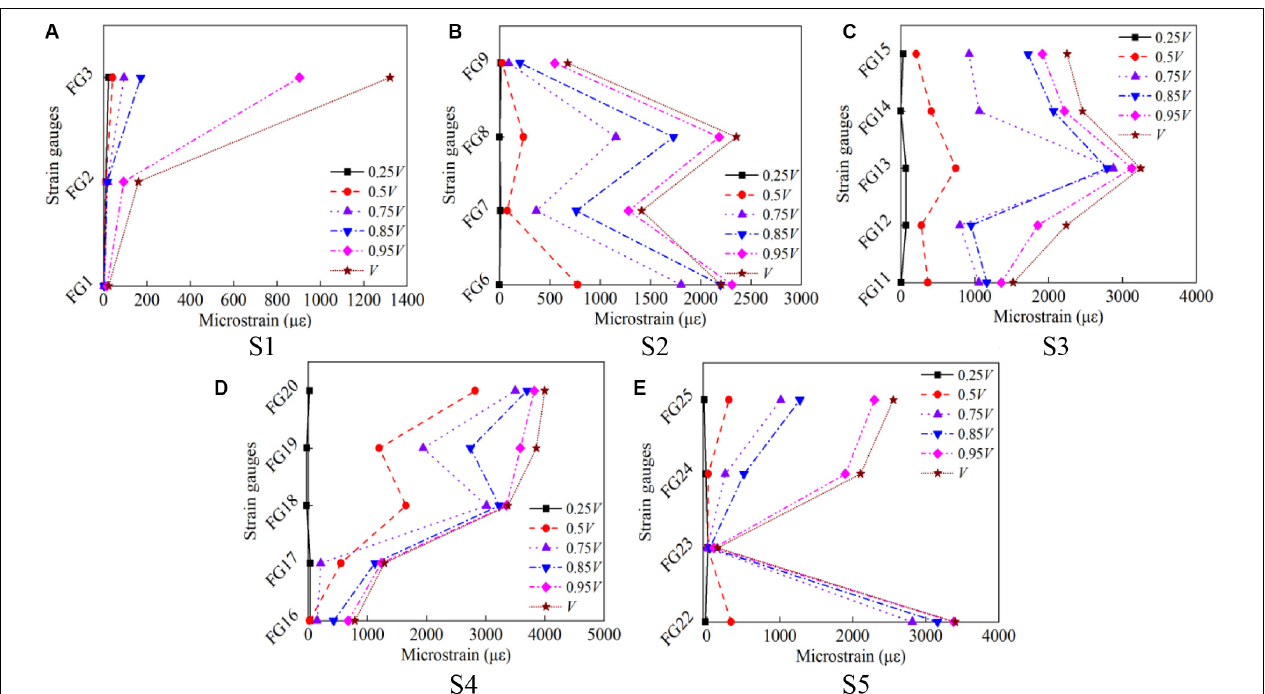
FIGURE 14 | Strain distribution along the height of CFRP strips for EA-4-0. (A) S1. (B) S2. (C) S3. (D) S4, and (E) S5.